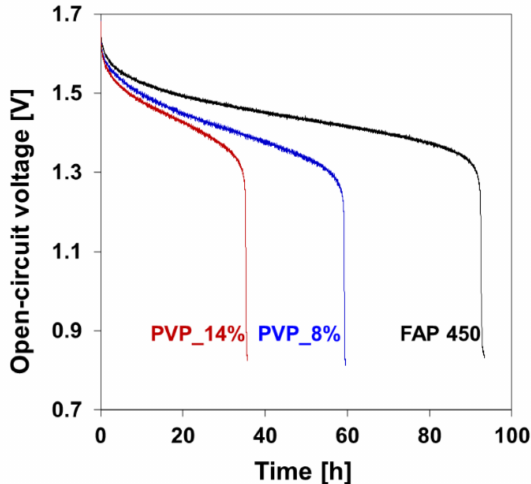
Figure 5. Open-circuit voltage as a function of time–self discharge curve recorded for FAP 450 and two composite membranes (PVP_14% and PVP_8%).